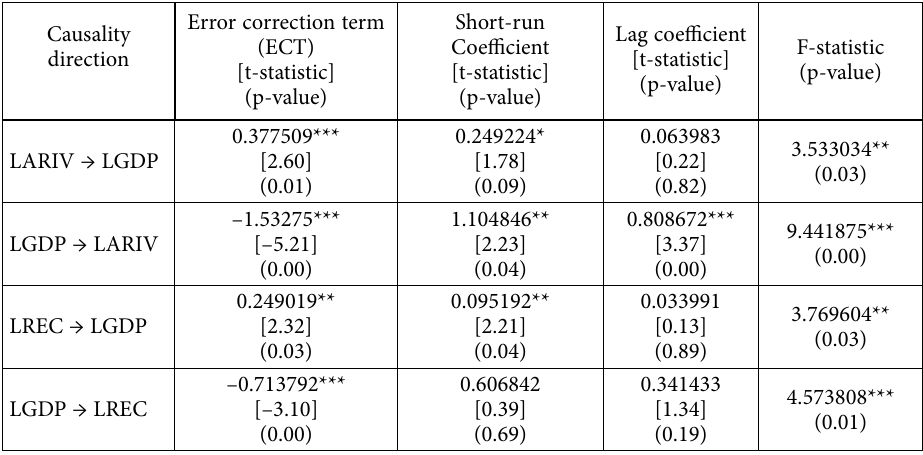
Table 5. VECM and Granger causality tests (source: authors’ estimates using Eviews 9) Causality direction